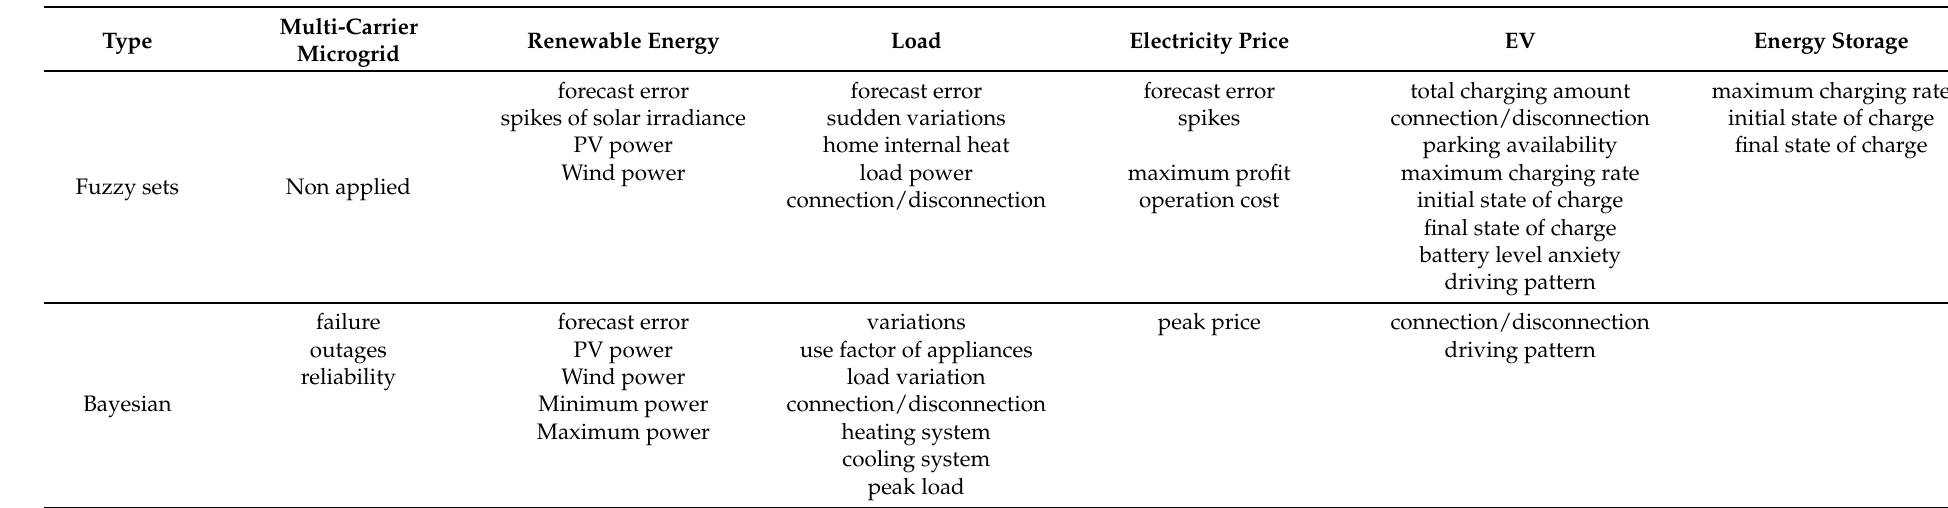
Table 4. Modeling uncertainties with possibility